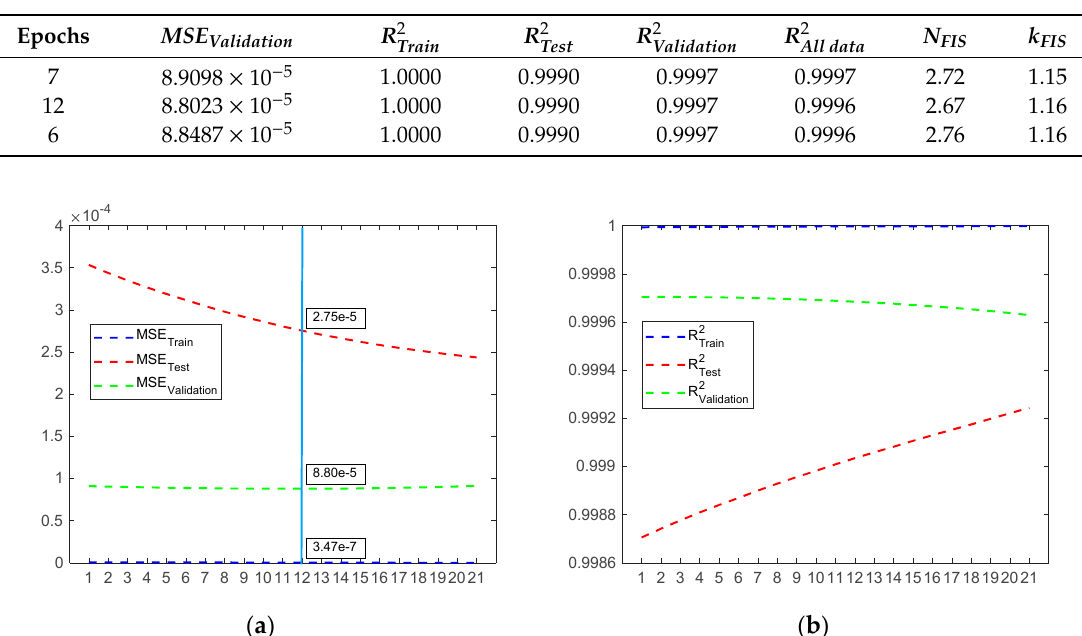
Table 8. Iteration to find N FIS and k FIS for modeling f 1 function.